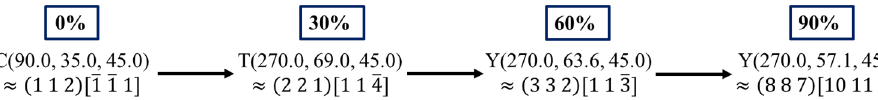
Figure 9. Orientation evolution of Y orientation simulated with MCTS-model.